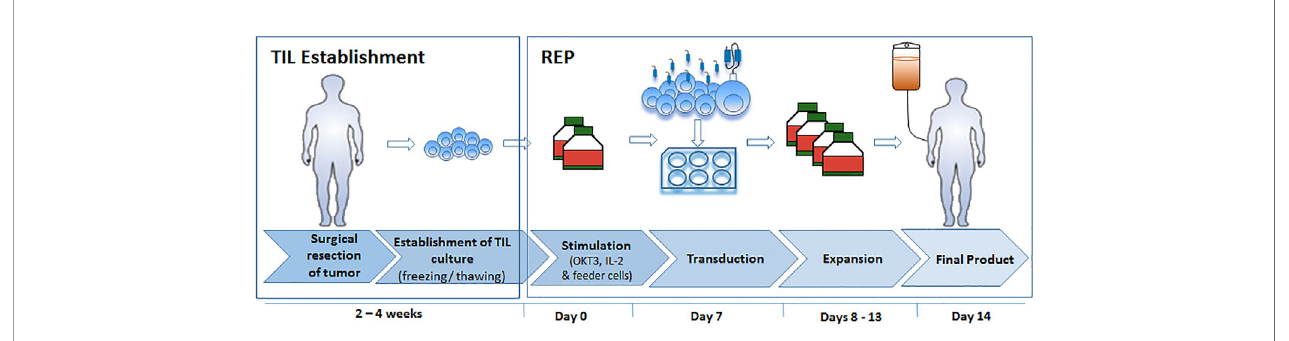
FIGURE 5 | Flowchart of optimized TIL expansion